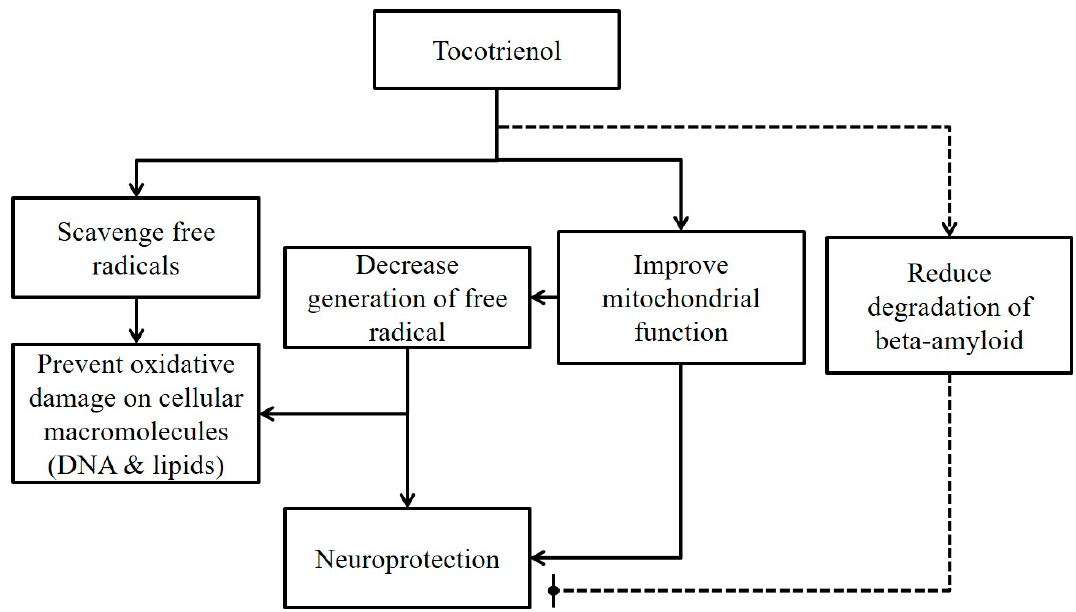
Figure 1. A summary of the current in vitro evidence of neuroprotective actions of tocotrienol. Legend: Solid line represents beneficial effects of tocotrienol on neurons. The dotted line presents potential adverse effects of tocotrienol on neurons.